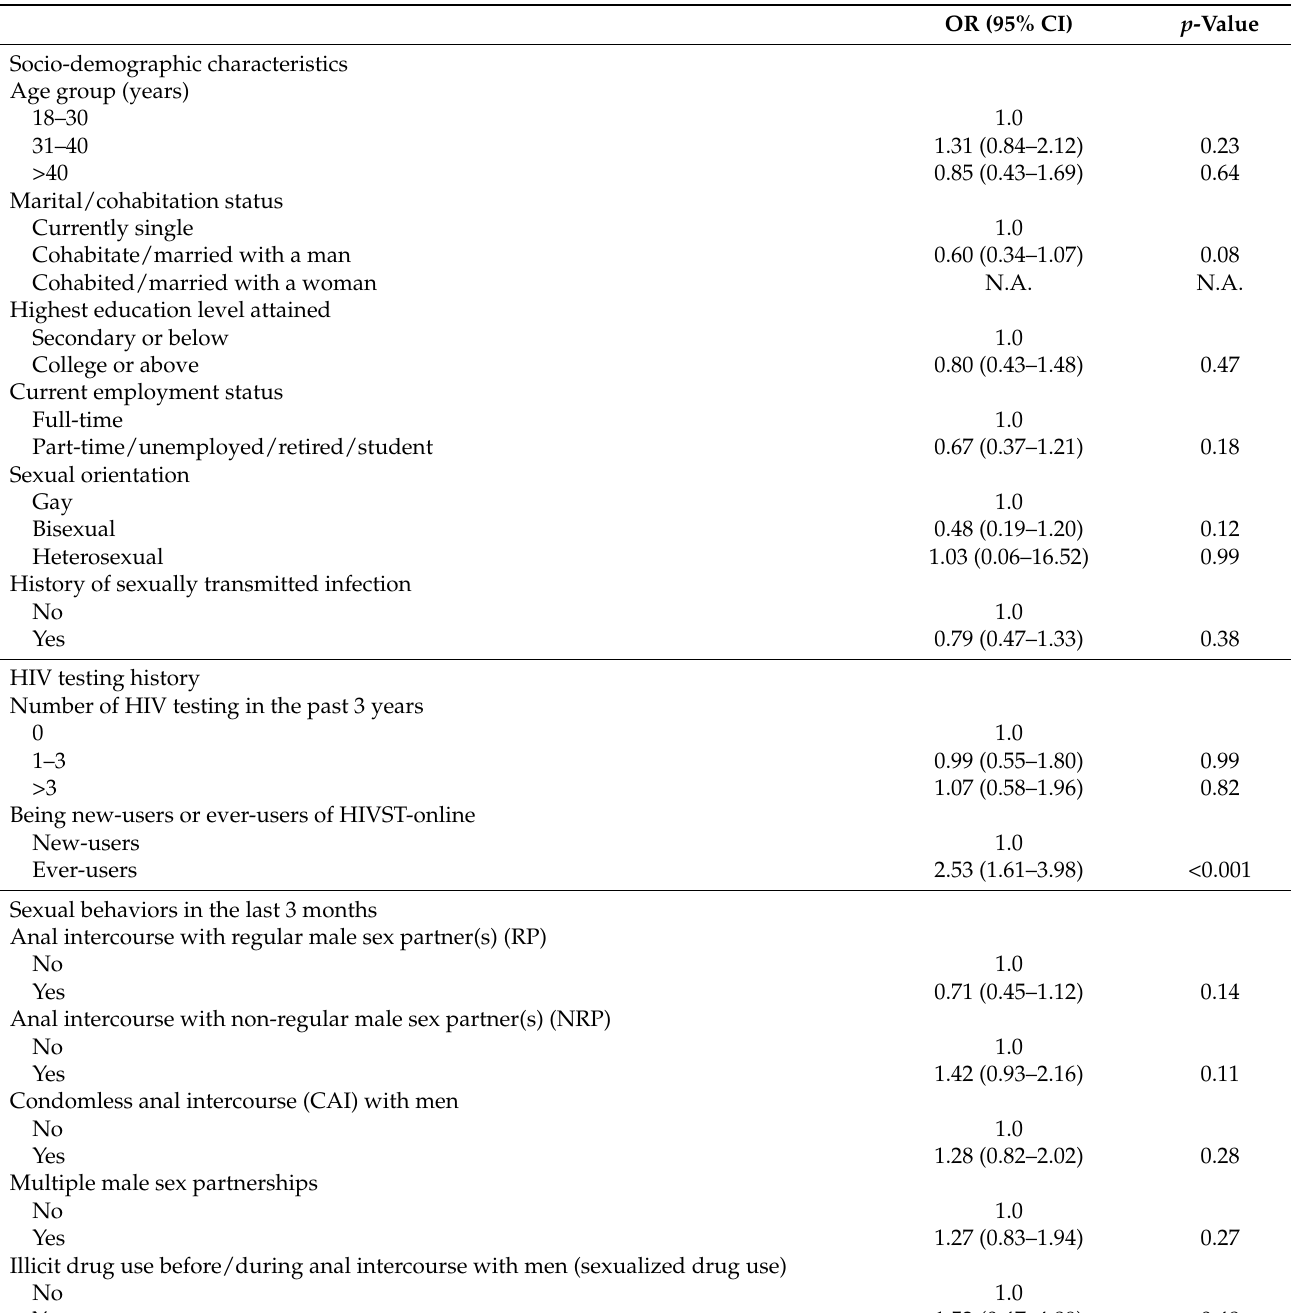
Table 3. Baseline background variables predicting the uptake of HIVST-online ( n =